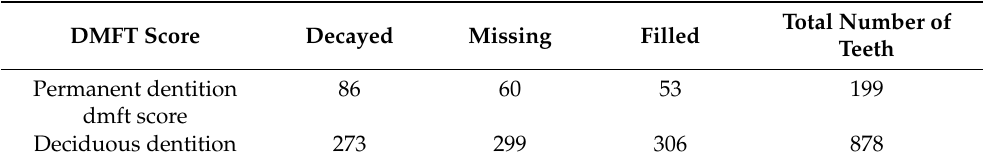
Table 2. Distribution of decayed, missing, and filled teeth in permanent and deciduous dentition ( n =